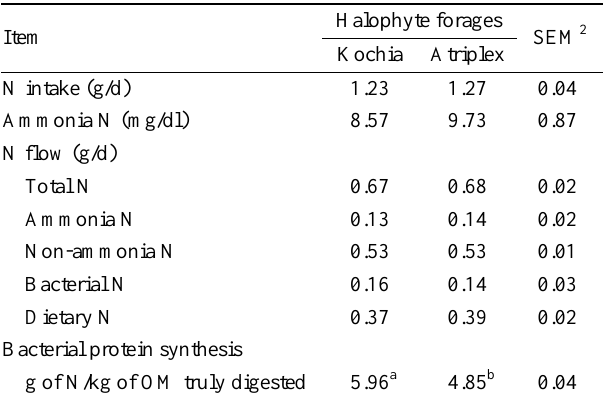
Table 4. Nitrogen metabolism of Kochia scoparia and Atriplex dimorphostegia in continuous culture fermenters